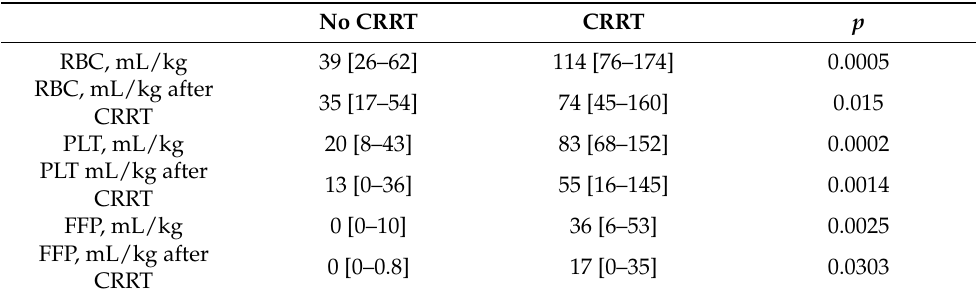
Table 5. Marked effect of CRRT on blood derivative consumption.